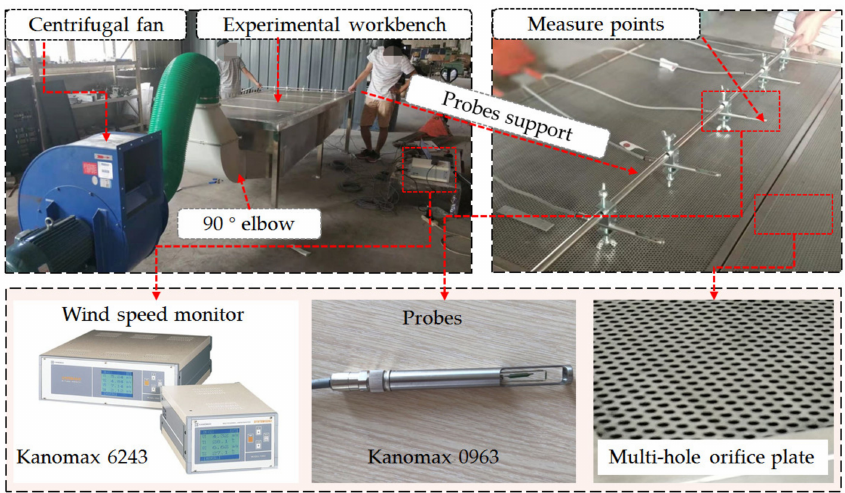
Figure 6. Experimental validation of lower exhaust workbench and measurement